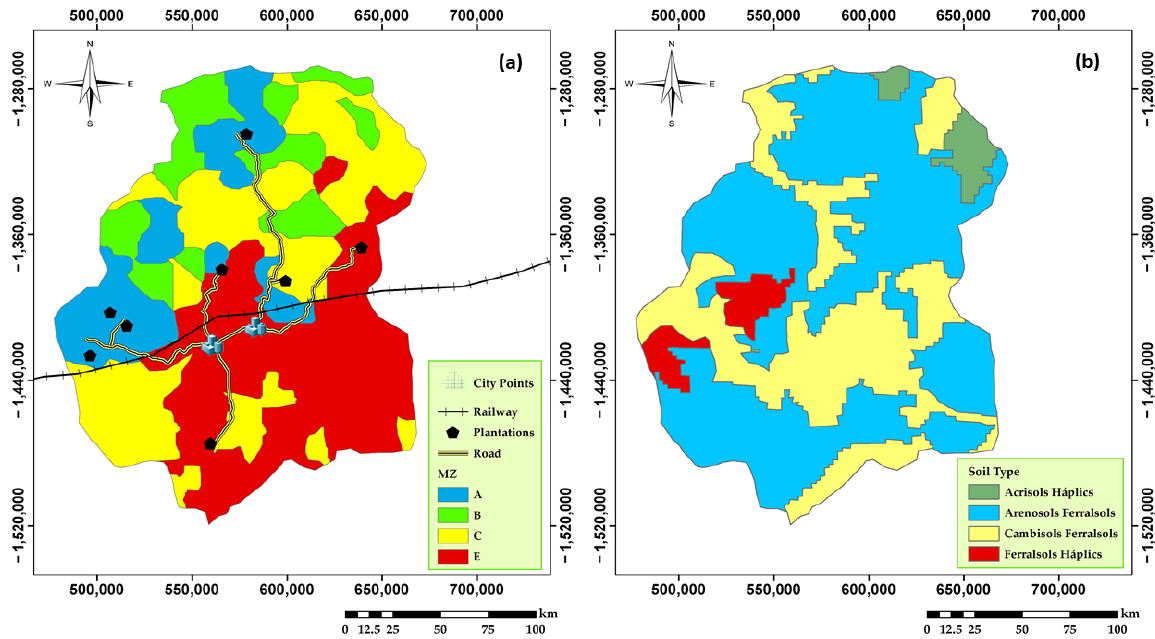
Figure 6. ( a ) Distribution of roads inside the management zones (MZ) based on the land cover changes [6] and ( b ) classification of soil types into 4 classes.